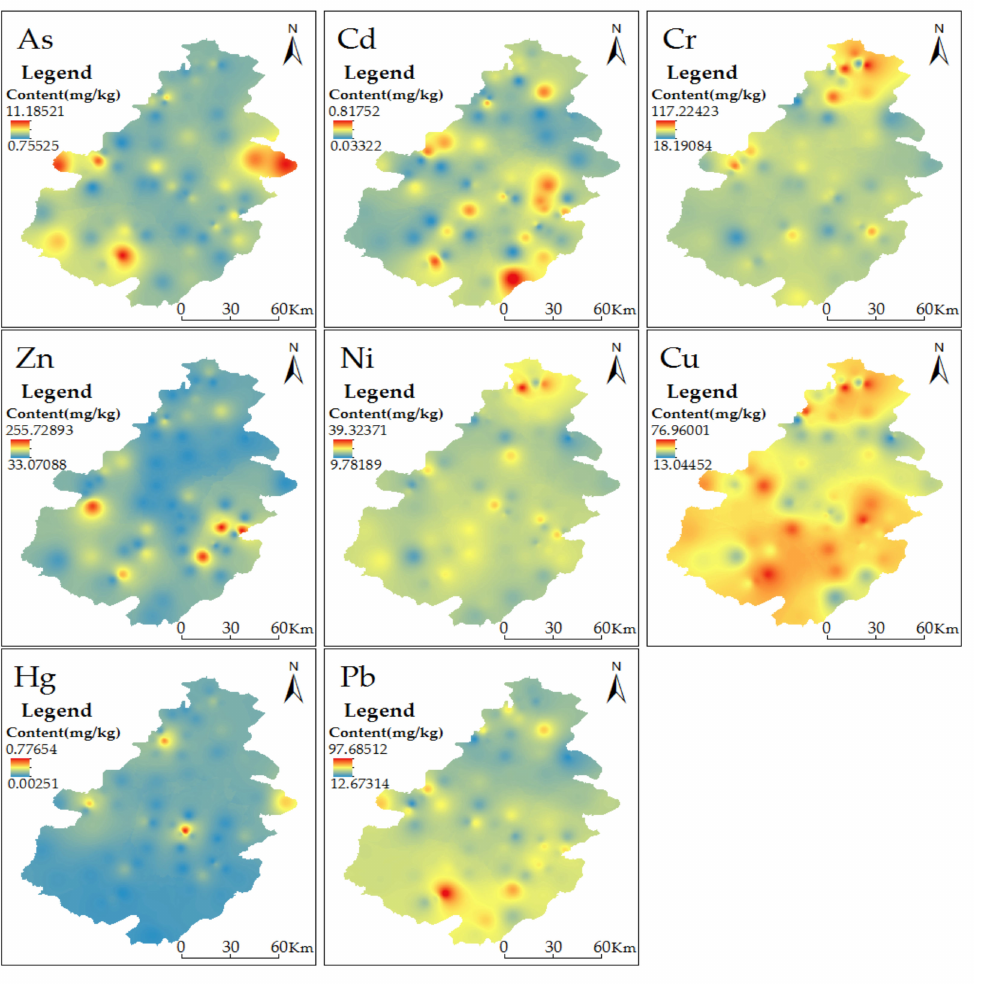
Figure 2. Spatial distribution of Potentially Toxic Elements